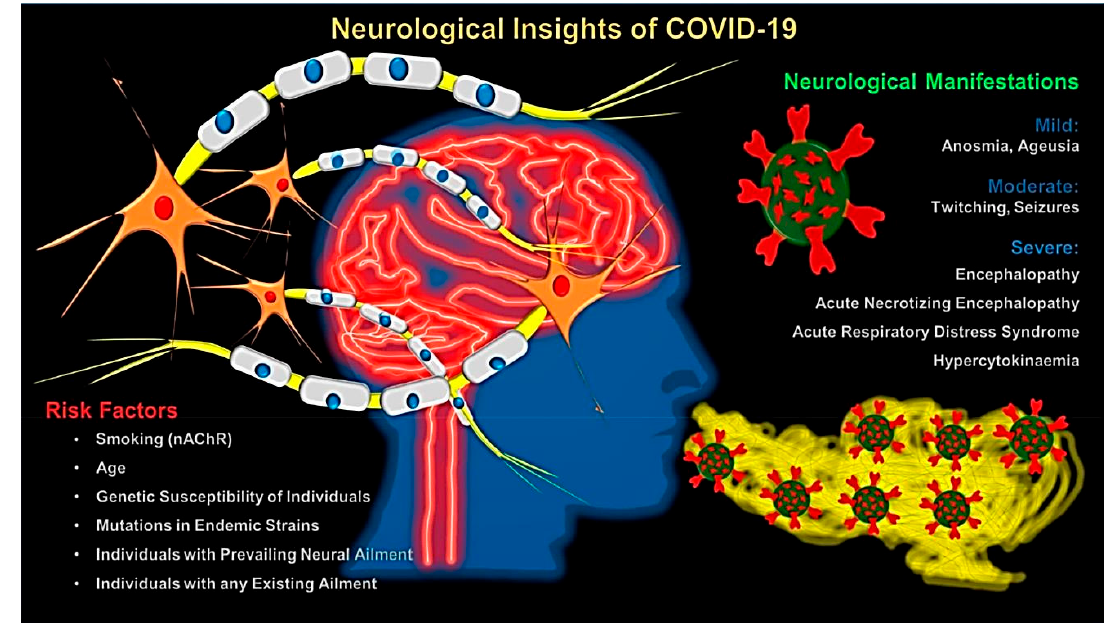
Figure 13. Neurological insights of COVID-19. Reproduced with permission from Ref. [68].